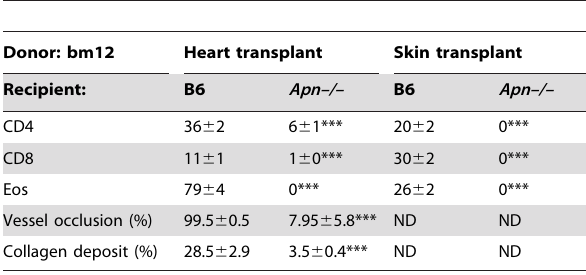
Table 1. Cellular infiltration, vasculopathy and tissue fibrosis in heart and skin grafts.